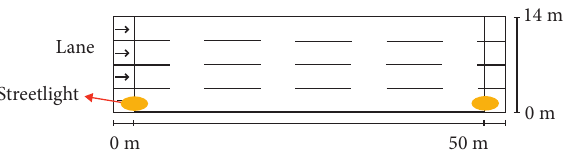
Figure 7: Schematic diagram of the trial road